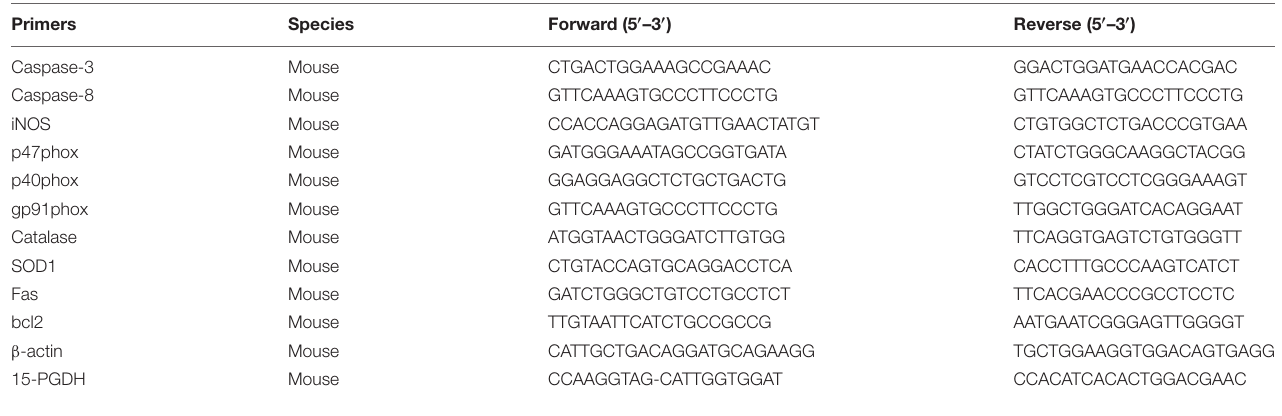
TABLE 1 | The sequences of